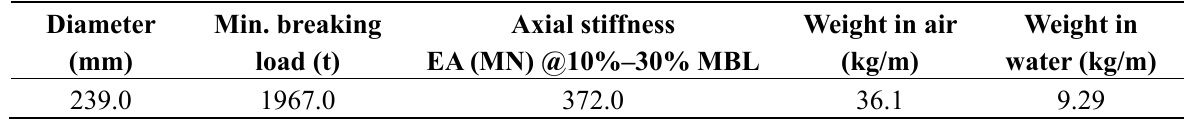
Table 5. Principal properties of the tendon ropes